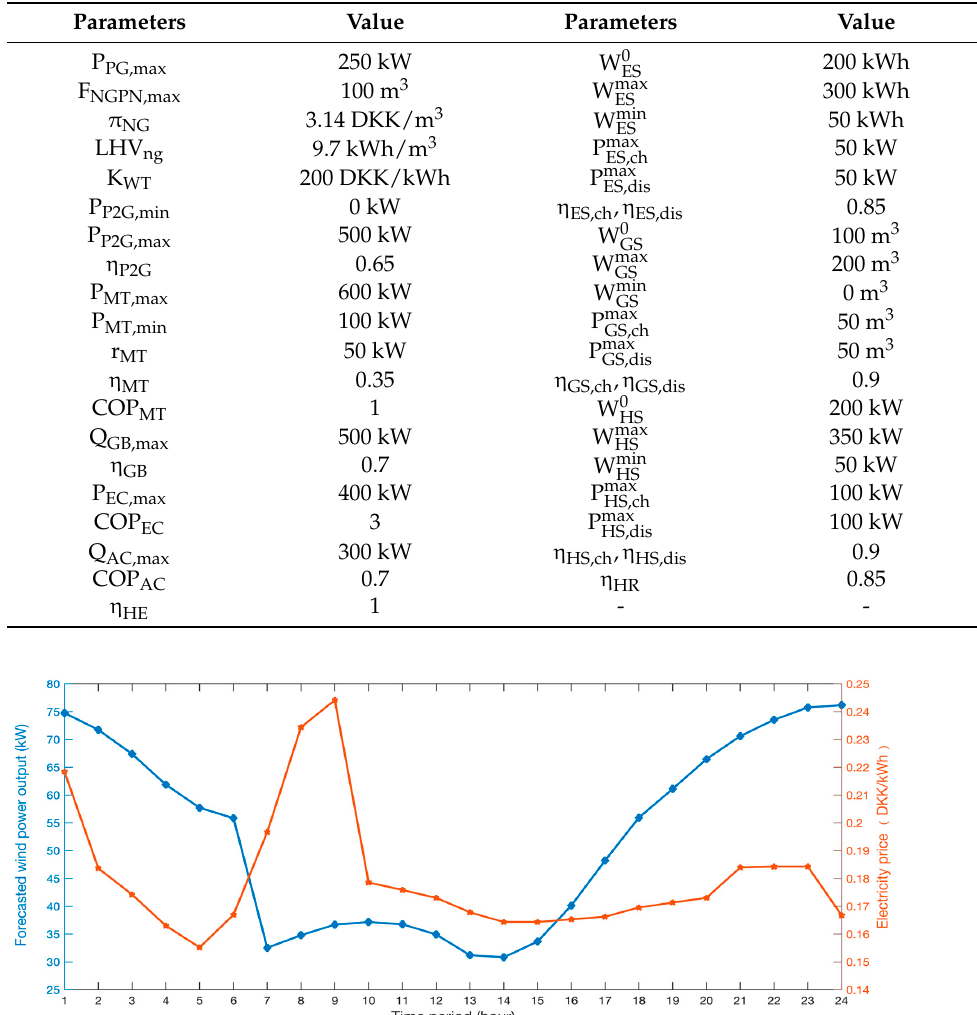
Table 1. Relevant parameters for components in the MGS.